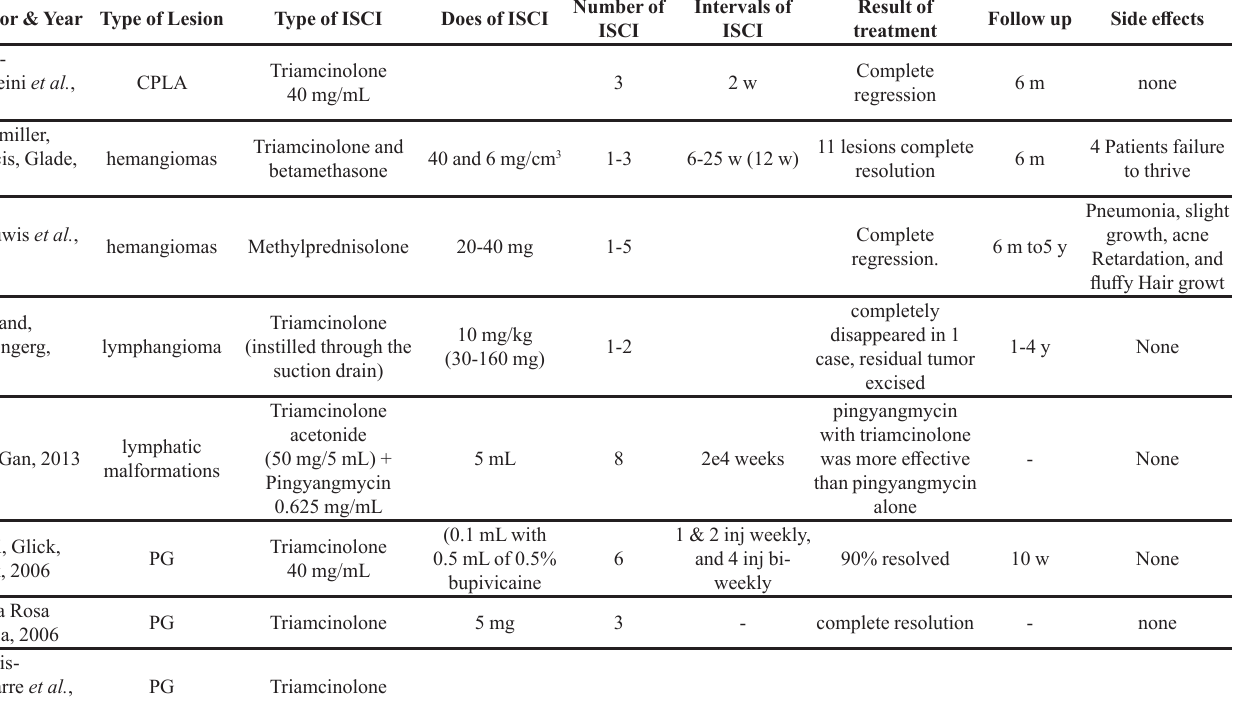
TABLE I - List of articles that applied ICSI to treatment oral